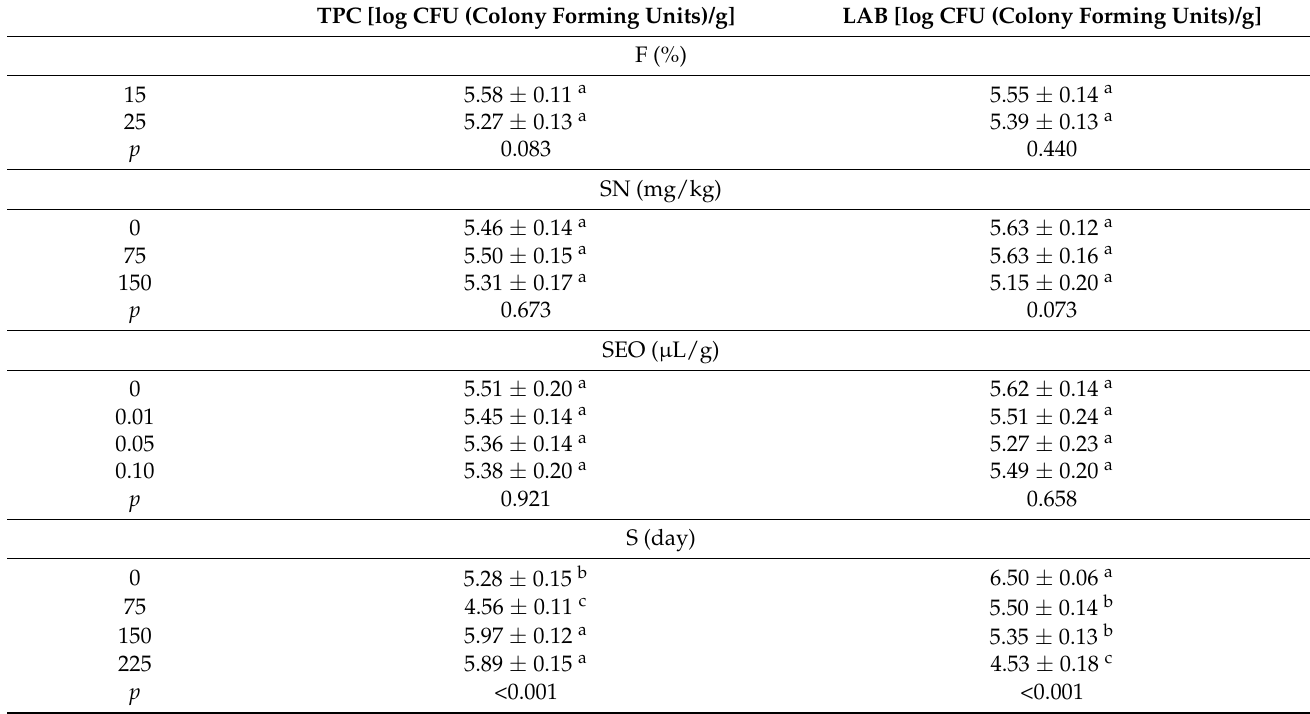
Table 5. Microbiological profile of